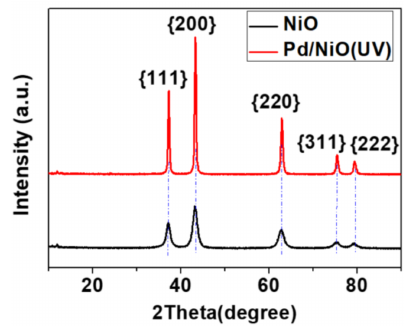
Figure 1. X-ray diffraction patterns of NiO and UV-irradiated Pd/NiO